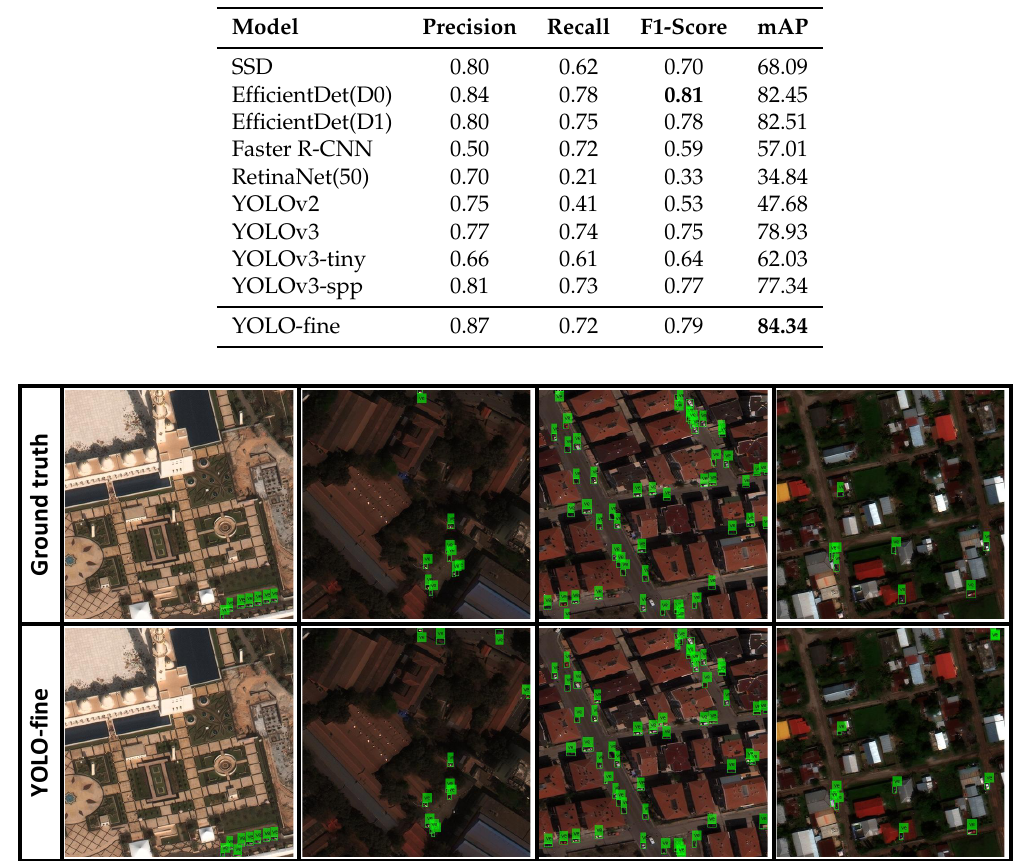
Figure 10. Illustration of detection results on